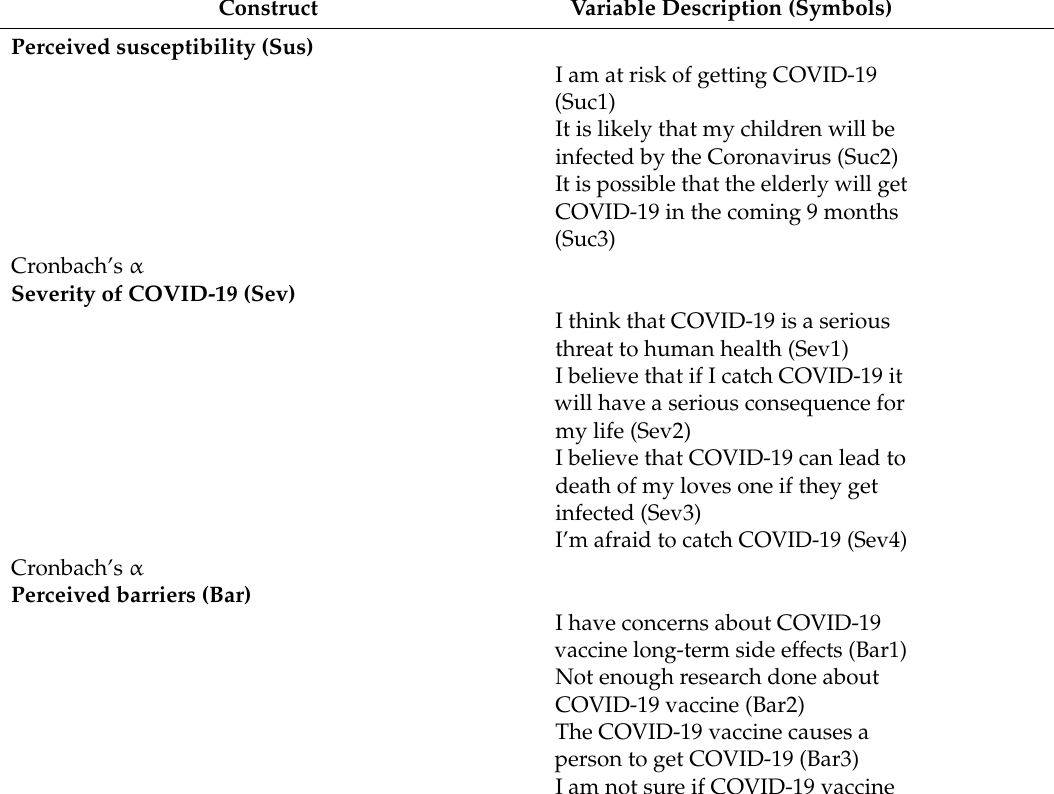
Table 3. Descriptive statistics of key variables concerning COVID-19 vaccine acceptance ( n =